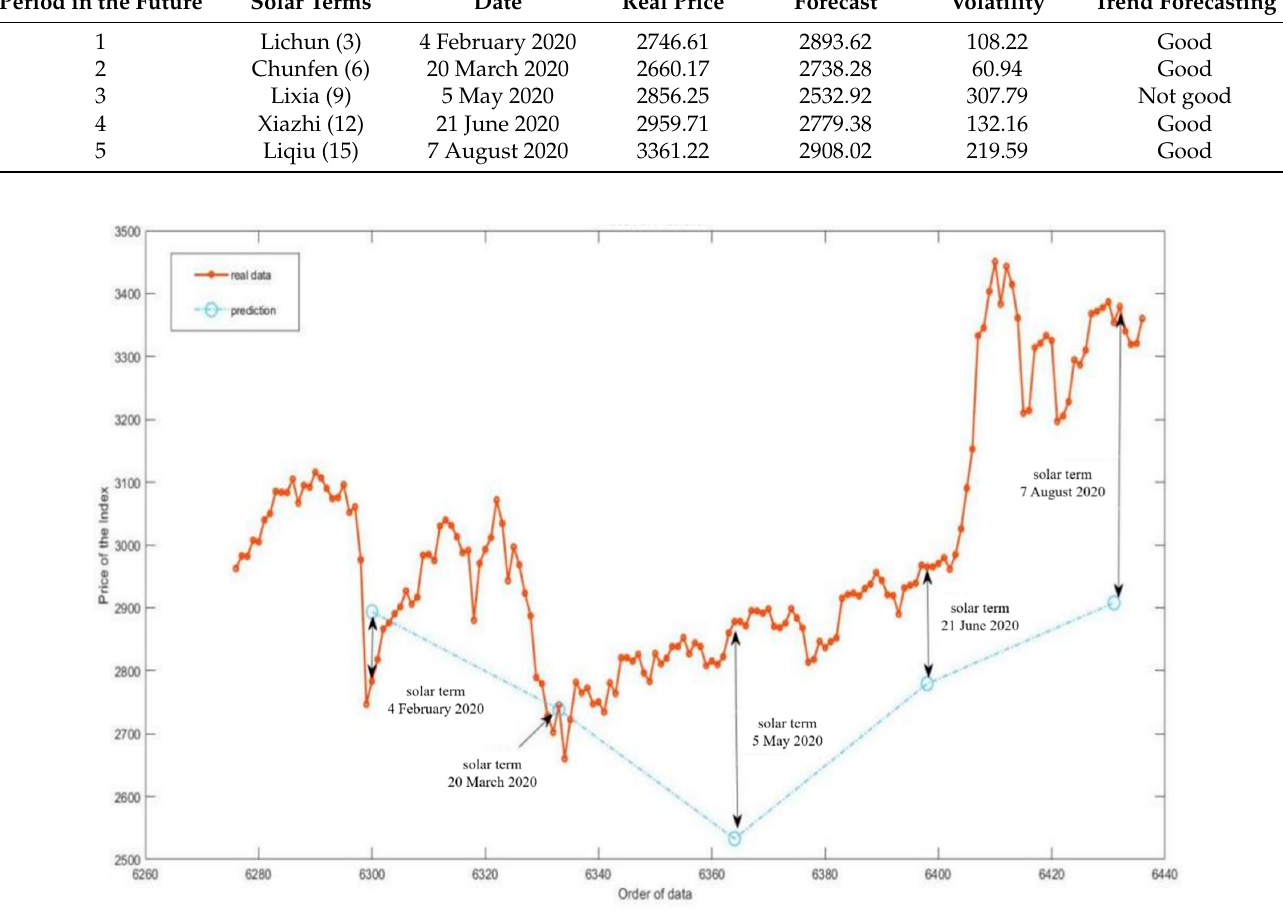
Figure 14. Comparisons between the forecast and real price in five periods in the future of the Shanghai Index (eight-terms group). Table 15. Forecasts of the eight-terms group of the Second Board Index.